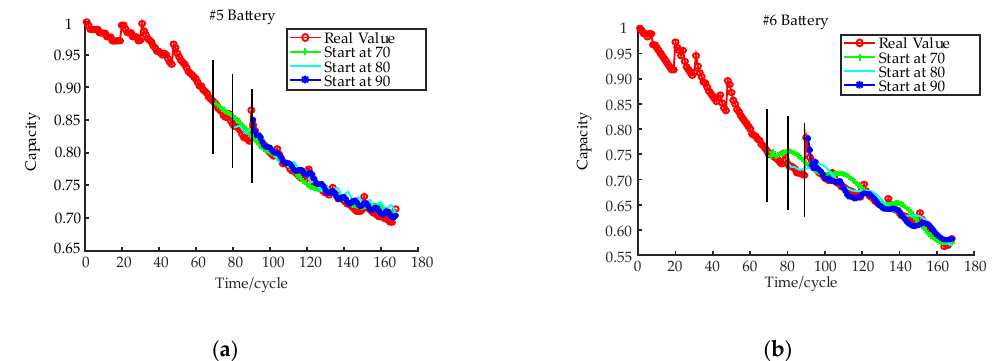
Figure 9. Charge capacity prediction of M1 at three di ff erent prediction starting points: ( a ) #5 battery; ( b ) #6 battery. Table 3. Prediction error of model M1 at three prediction starting points. Battery Prediction Starting